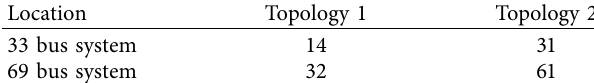
Table 5: Optimal location of